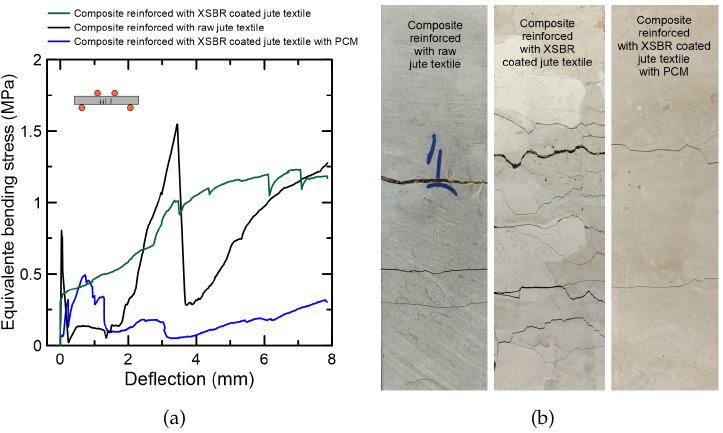
Figure 14. Results of four-point bending tests on the composites: typical curves ( a ) and cracks formed during tests ( b